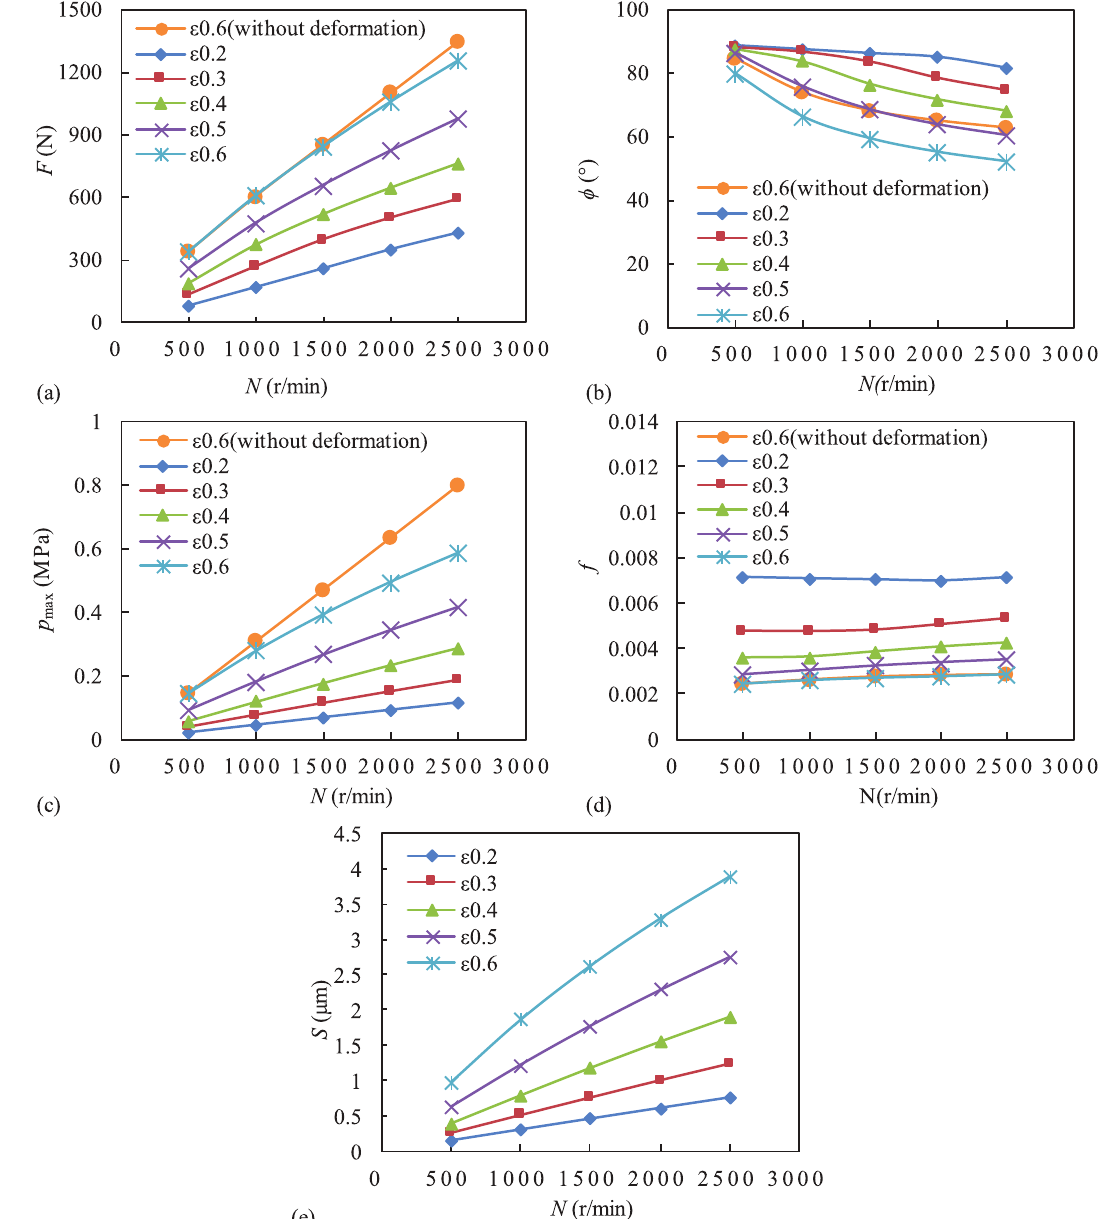
Fig. 9. Effect of eccentricity ratio on the lubrication performance of double-layer bearing (a) Load carrying capacity, (b) Attitude angle, (c) Maximum water fi lm pressure, (d) Friction coef fi cient, (e) Maximum bearing bush deformation, for t1 = t2 = 5 mm, E1 = 1000 MPa, E2 = 400 MPa, n1= 0.4, n2 =